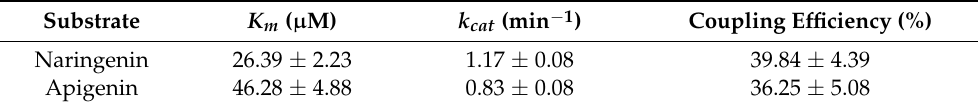
Figure 3. Determination of the kinetic parameters of naringenin and apigenin catalyzed by CYP101D5. The overall kinetic parameters were determined using CYP:Pdx:PdR at a ratio of 1:8:2. Hyperbolic fits of the hydroxylated products of naringenin ( A ) and apigenin ( B ) are shown. The bars on each point represent the standard deviation of the individual experiments. Table 1. Michaelis–Menten constant ( Km ), catalytic rate constant ( k cat ), and coupling of naringenin and apigenin by CYP101D5. The calculation of the kinetic parameters was performed using a CYP:Pdx:PdR ratio of 1:8:2. Coupling efficiency was calculated as the fraction of NADH utilized for product formation over the total consumption of NADH. The background NADH consumption rate was subtracted to calculate the actual NADH consumption rate. The results represent the mean values of triplicate